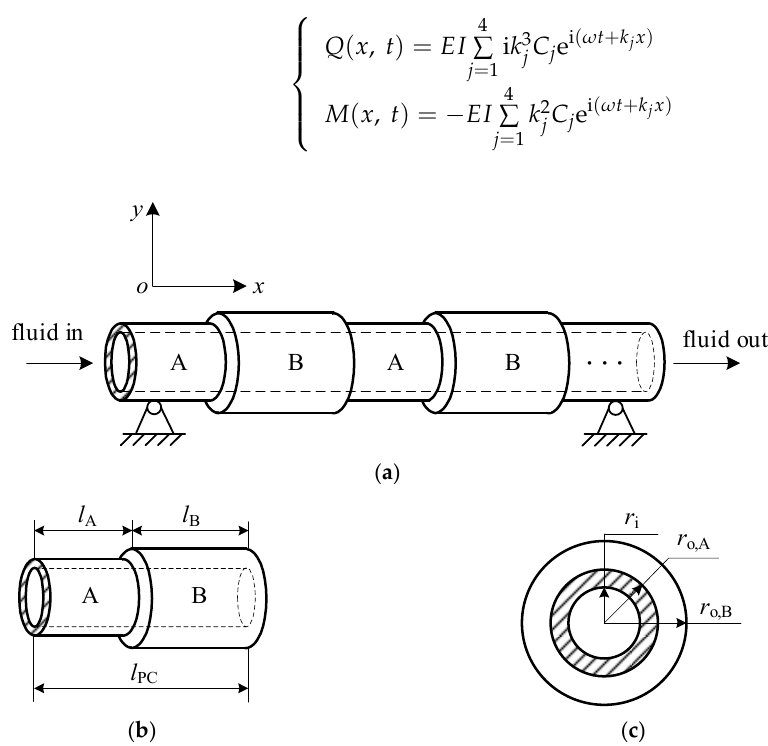
Figure 1. Mechanical model of a fluid-conveying PC pipe with periodically varying cross-section: ( a ) model with n cells, ( b ) a single cell, ( c ) cross-section of the pipe.